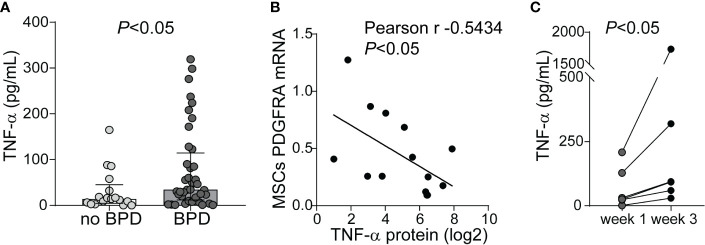
TNF-α protein levels in tracheal aspirates from human infants receiving mechanical ventilation for respiratory distress syndrome. (A) Tracheal aspirates were collected in the first week of life. Supernatant was assayed for TNF-α. Comparison by Mann–Whitney test. (B) Tracheal aspirate TNF-α protein levels (log2-transformed) positively correlated with MSCs PDGFRA mRNA expression. (C) For patients who remained endotracheally intubated receiving mechanical ventilation tracheal aspirates were obtained during week 1 and week 3 of mechanical ventilation, and TNF-α levels were quantified. Statistical significance was pointed by Wilcoxon matched-pairs test.